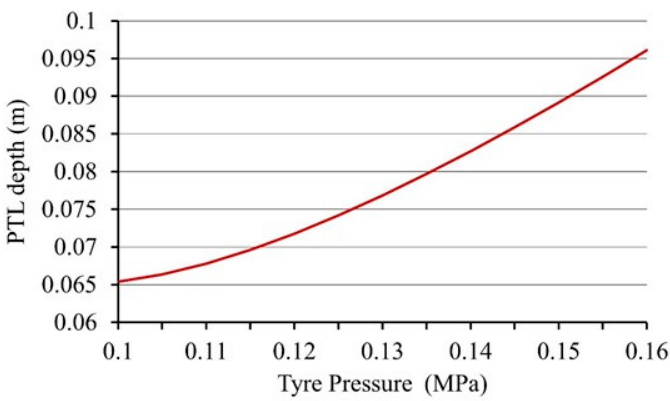
Figure 4. Dependence of the track depth PTL ( h ) on the tractor tire inflation pressure ( P w ). As the vertical load N w on the wheel increases, the parameter h changes in direct proportion, and therefore according to the straight-line law (Figure 5).